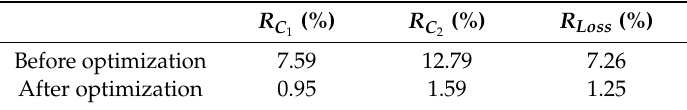
Table 8. Performance comparison before and after